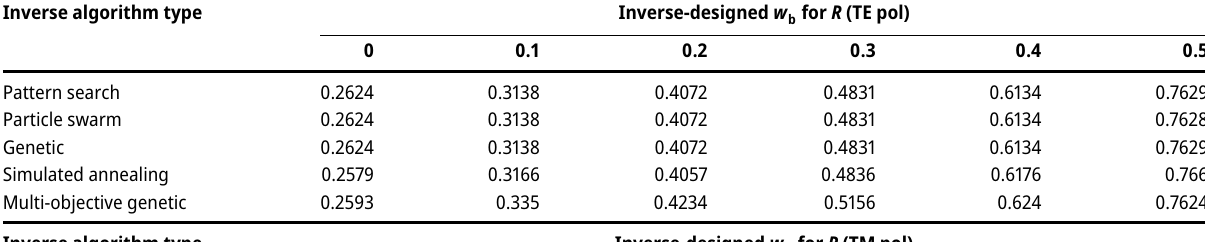
Table 2: The inverse-designed values of the geometrical parameters ( w u , w b ) for various R found by various inverse algorithms for a fixed L = 2 μ m. Inverse algorithm type